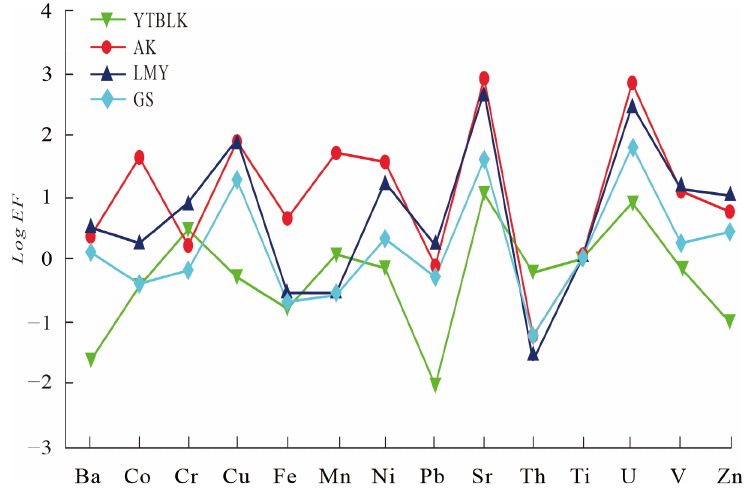
Figure 3. Enrichment coefficients of trace element in the hot springs.